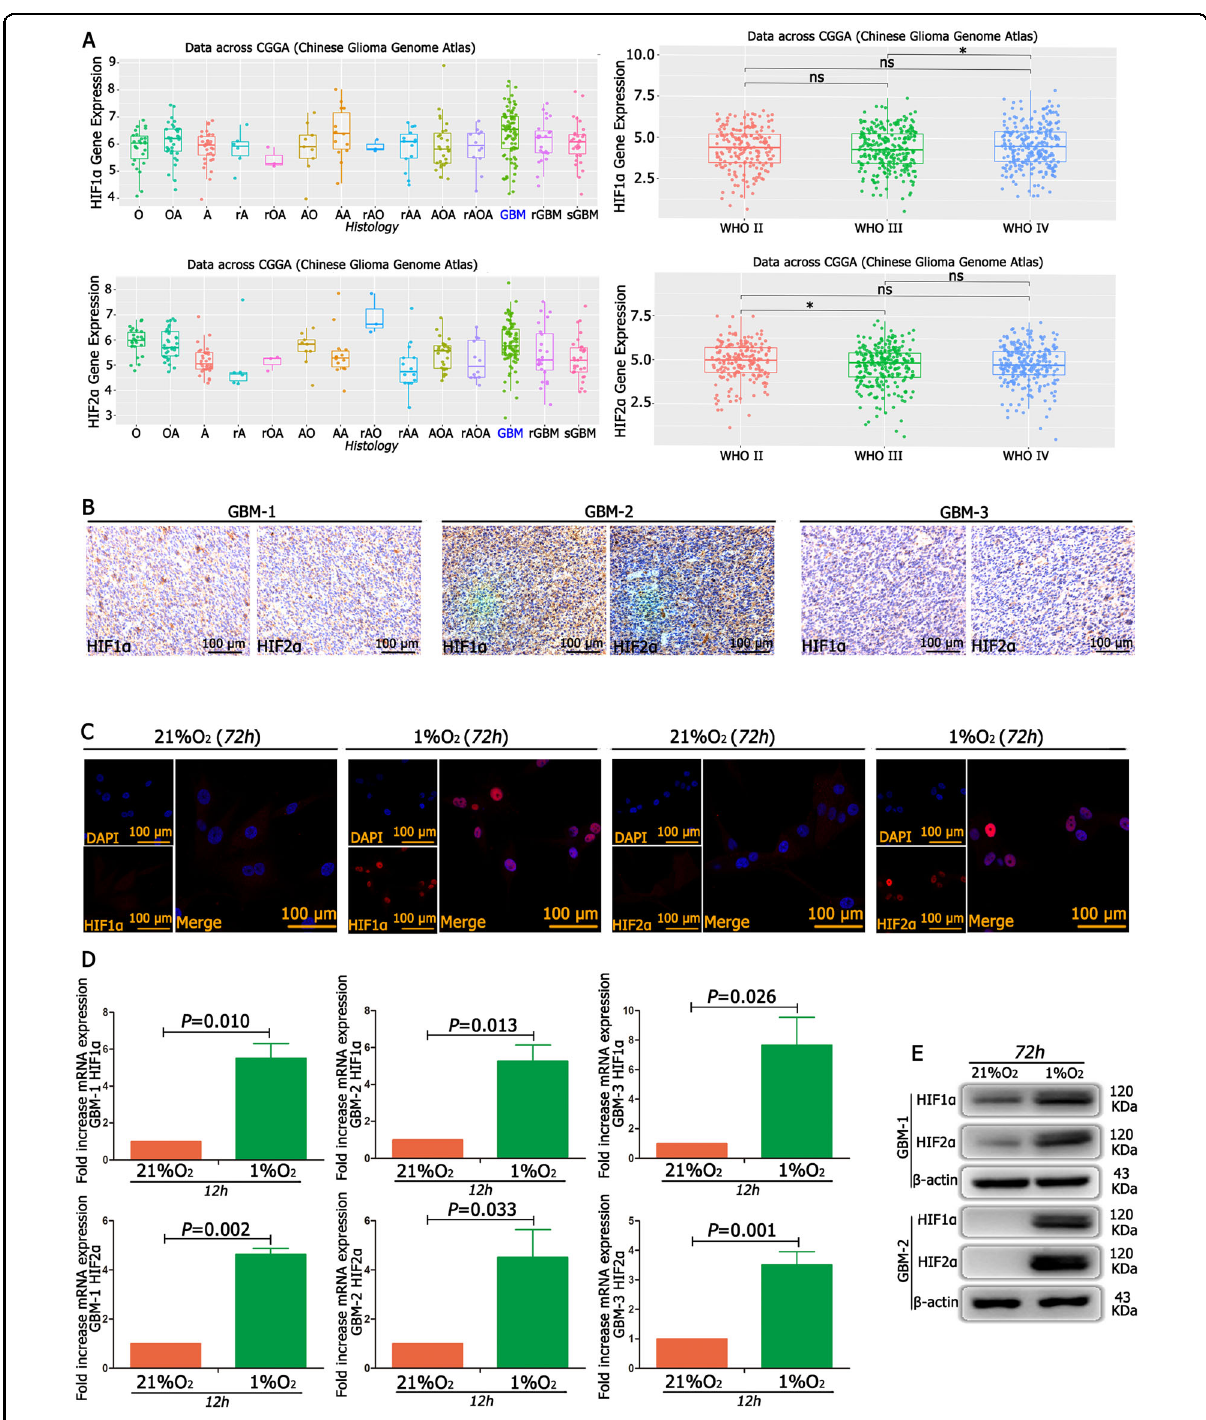
Fig. 1 HIF1 α and HIF2 α were highly expressed in GBM under hypoxic conditions. A The CGGA database showed that both HIF1 α and HIF2 α were highly expressed in GBM. B Primary GBM tissues showed high levels of HIF1 α and HIF2 α expression using immunohistochemistry detection. C GBM cells exposed to 21% O 2 and 1% O 2 for 72 h showed that there was a much higher expression of HIF1 α and HIF2 α in cells cultured in 1% O 2 than in cells cultured in 21% O 2 . D , E GBM cells cultured in 21% O 2 and 1% O 2 demonstrated that both HIF1 α and HIF2 α were highly expressed in 1% O 2 , while there was almost no HIF1 α and HIF2 α expression under 21% O 2 conditions. P values were determined by the independent samples t